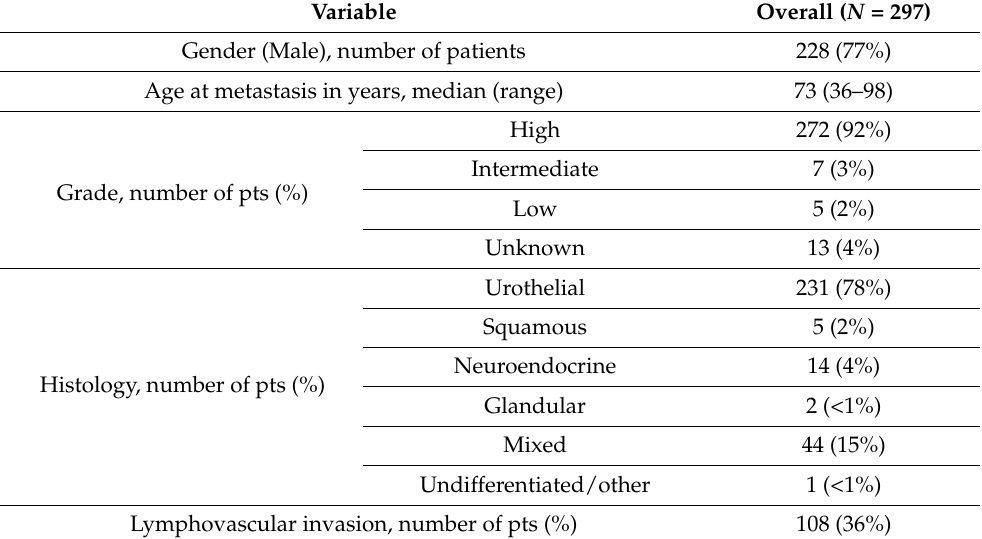
Table 1. Patient, disease, and treatment characteristics of the overall